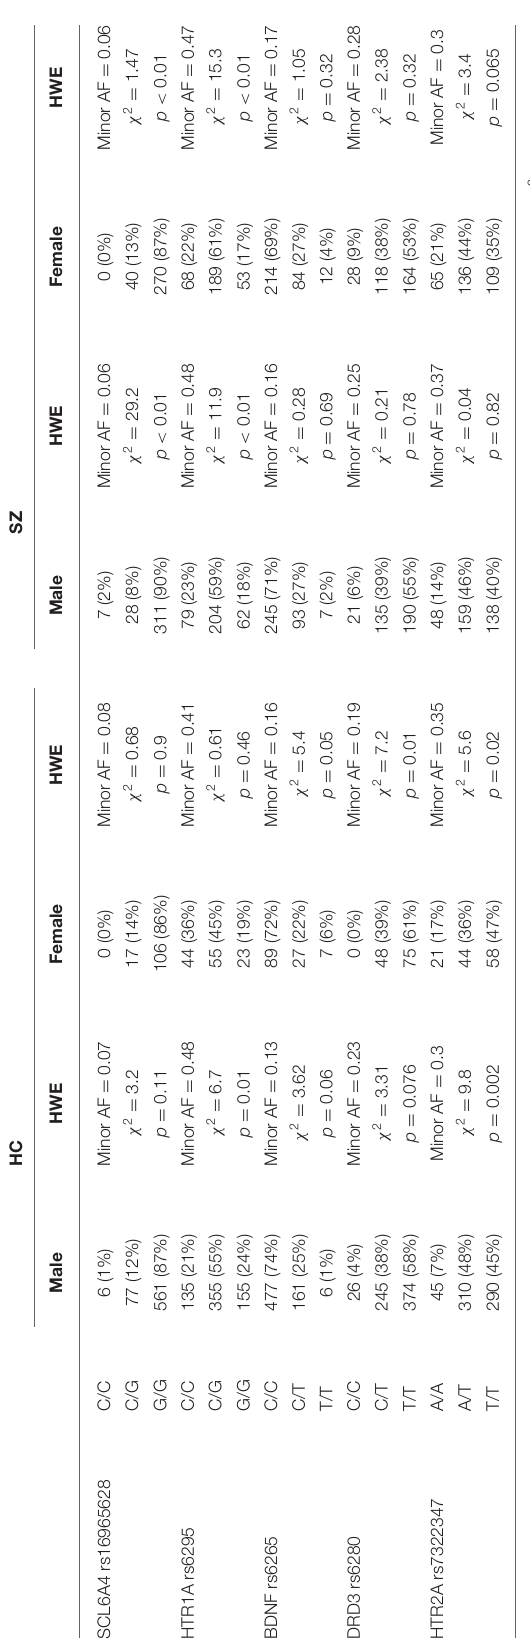
( F = 5.04 p = 0.007); 3. Motor Series ( F = 3.96 p = 0.019); 4. Conflicting Instructions ( F = 4.16 p = 0.0016); 5.